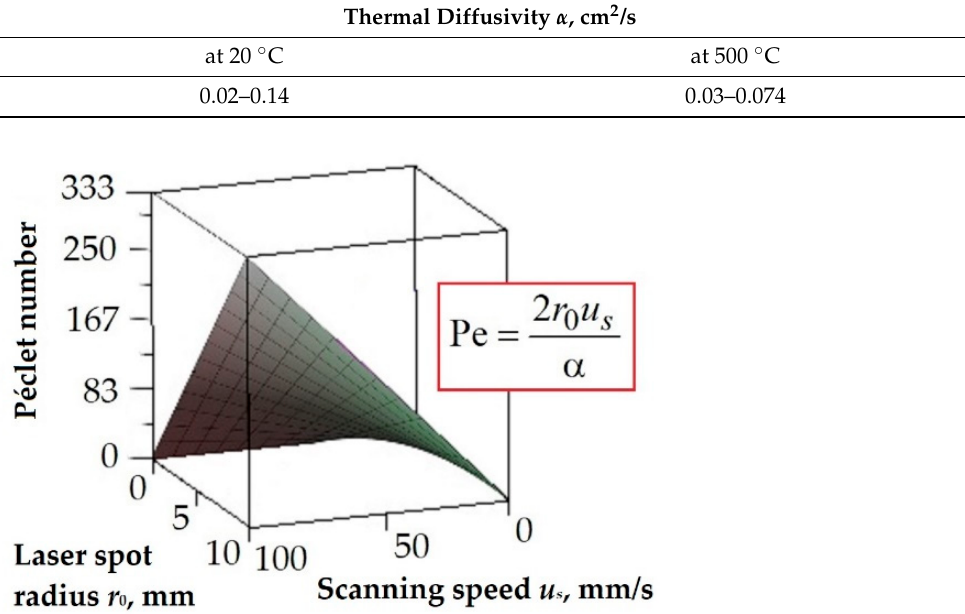
Figure 8. The implicit graph of the Péclet number on the laser spot radius and scanning speed for a cobalt-chromium alloy ( α = 5.2 × 10 − 6 m 2 /s) (3D-plot). Figure 9 shows the calculated temperature fields for two types of laser beam profiles: TEM 00 and TEM 01* at laser powers of 100 and 400 W, correspondingly, when laser beam di- ameters are 0.109 and 0.310 mm, respectively. The difference from Figure 2 is that laser beam profiles are shown at the level of calculated steady temperatures (Table 4). Formation of the temperature plateau is explained by a small value of overheating sufficient for evaporation under the given conditions. In the case of mode TEM 01* , the characteristic temperature sink is still visible in the center. The energy losses for evaporation are listed in Table 7. The corresponding mass losses are proportional to the energy ones [43]. Comparison of values listed in Table 7 indicates that the change from mode TEM 00 to mode TEM 01* decreases the evaporation loss for all four calculations made. Thus, the laser profile corresponding to mode TEM 01* seems to provide more efficient laser power density distribution (Figure